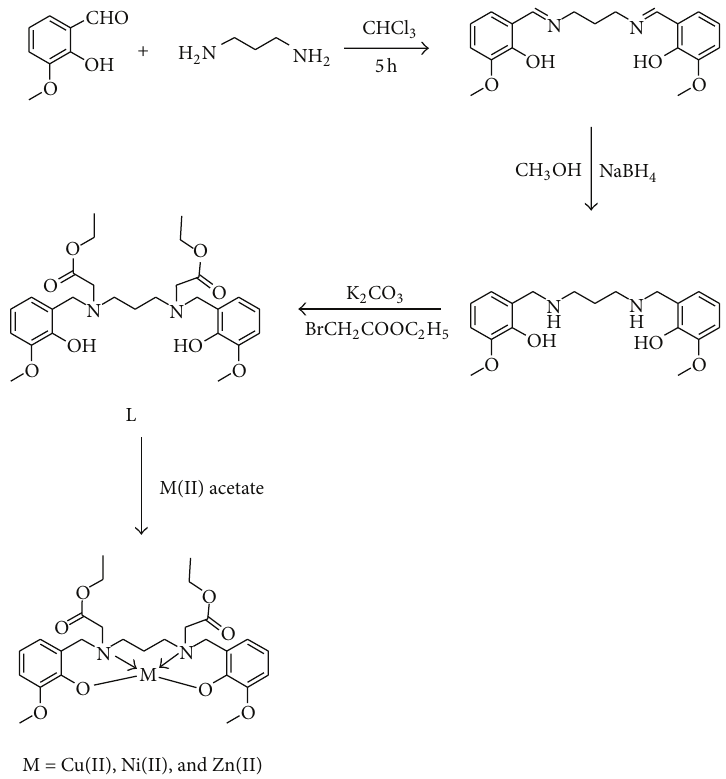
Scheme 1: Synthesis route for ligand and metal